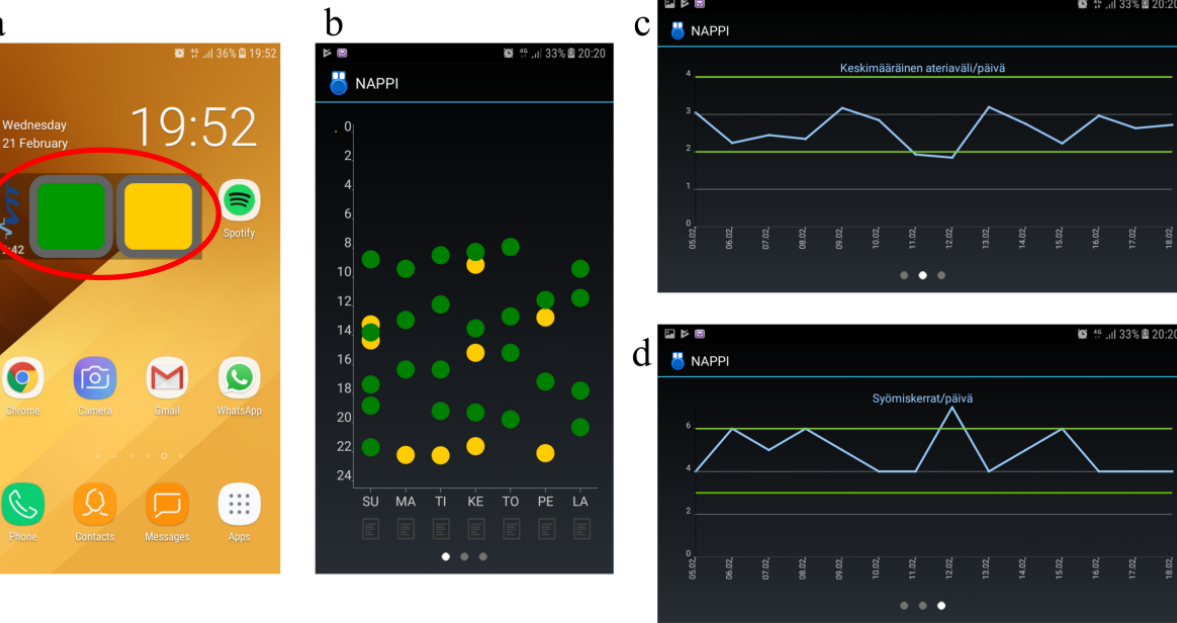
Figure 1. The Button widget with green and yellow buttons (circled) on mobile phone desktop (a) and visual summaries shown in the Button application (b-d). The user presses either green (content with eating occasion) or yellow (discontent with eating occasion) button of the widget after every eating occasion. The first visualization (b) in the application shows the eating occasions during the past seven days (weekdays on x-axis, time on y-axis), the second screen (c) shows the average interval between eating occasions per day during the past 14 days and, the third screen (d) shows the average number of eating occasions per day during the past 14 days. Green horizontal lines in c and d indicate the shortest (2 h) and longest (4 h) recommended interval between eating occasions and the smallest (3) and the highest (6) recommended number of eating occasions per